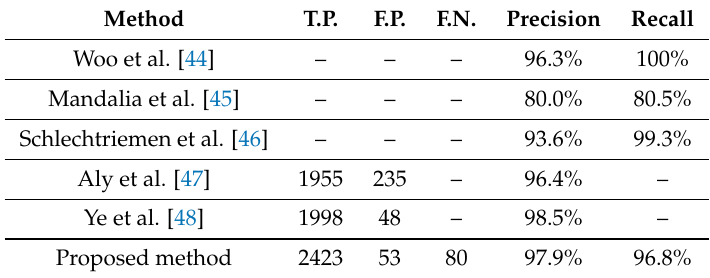
Table 1. The comparison of precision and recall of lane change detection for different algorithms. T.P.: true positive, F.P.: false positive, F.N.: false negative. Some previous works do not provide the numbers of true positives, false positives, false negatives, and recall rates.